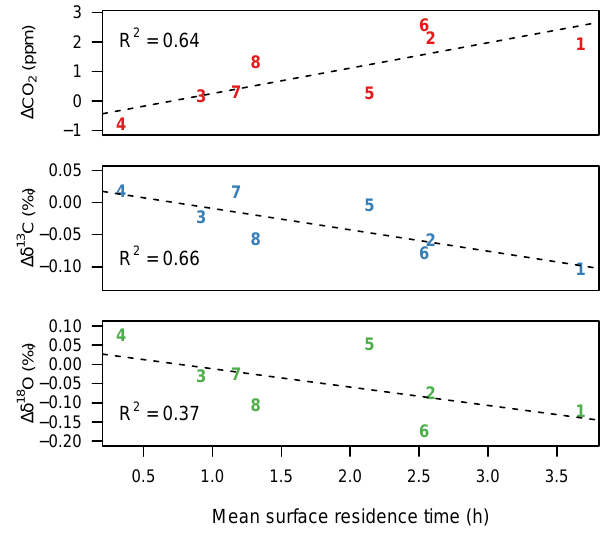
Fig. 11. Median 1 CO 2 , 1δ 13 C and 1δ 18 O of the eight footprint clusters as a function of the mean residence time within a layer of 100m above ground for the winter months (December to February). The colored numbers indicate the cluster index and the dashed lines are the ordinary least squares regression